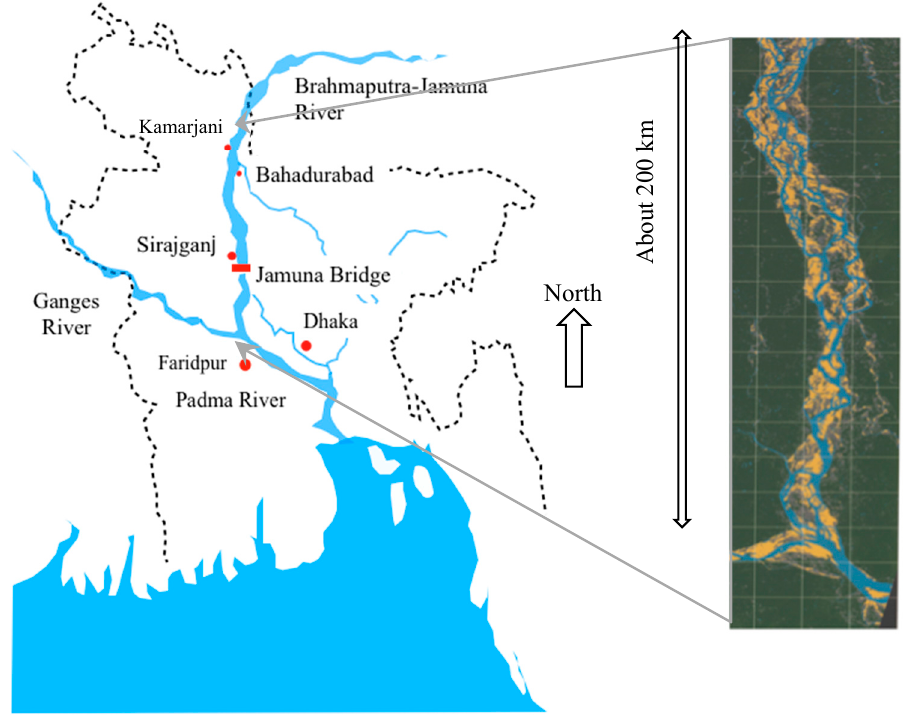
Figure 1. Main river system Bangladesh and historic planform Brahmaputra-Jamuna River (sketch prepared by the author).